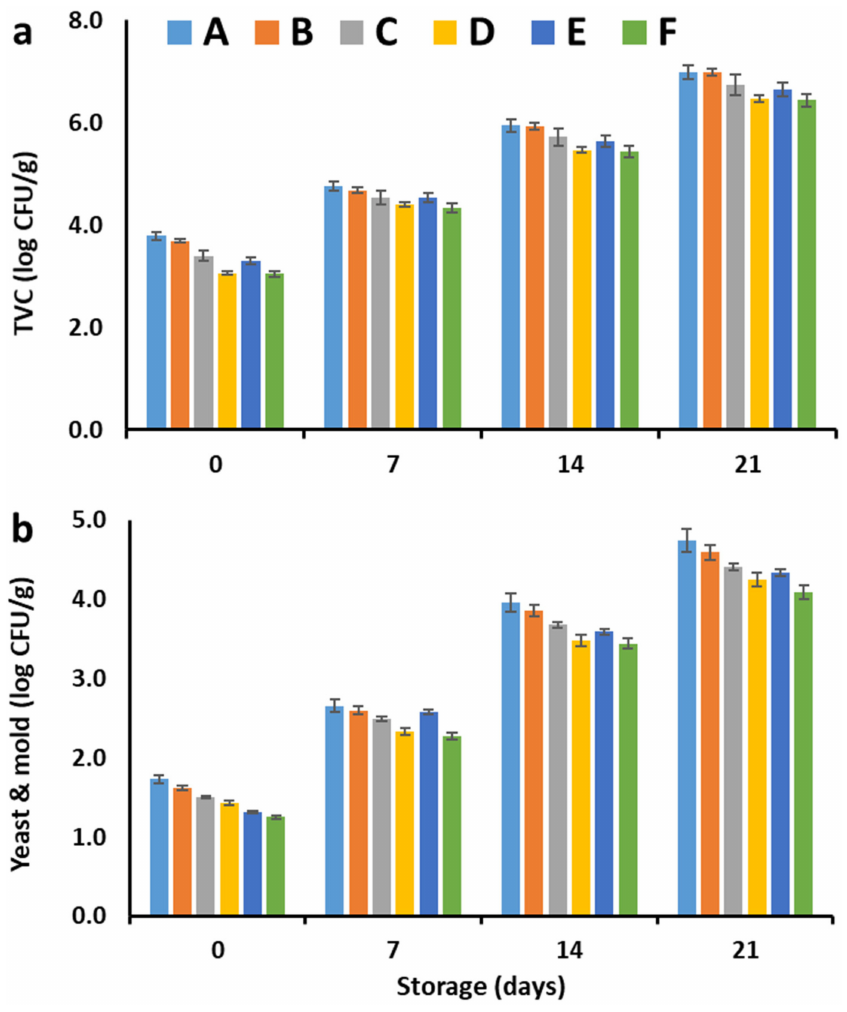
Figure 1. Changes in ( a ) total viable count (TVC) and ( b ) yeast & mold count of fresh cucumber coated with chitosan supplemented with different concentrations of olive cake extract (OCE) or orange peel extract (OPE) during cold storage (4 ◦ C). A: Uncoated, B: Coated with 2% chitosan only, C: Coated with 2% chitosan containing 1% OCE, D: Coated with 2% chitosan containing 2% OCE, E: Coated with 2% chitosan containing 1% OPE, and F: Coated with 2% chitosan containing 2%